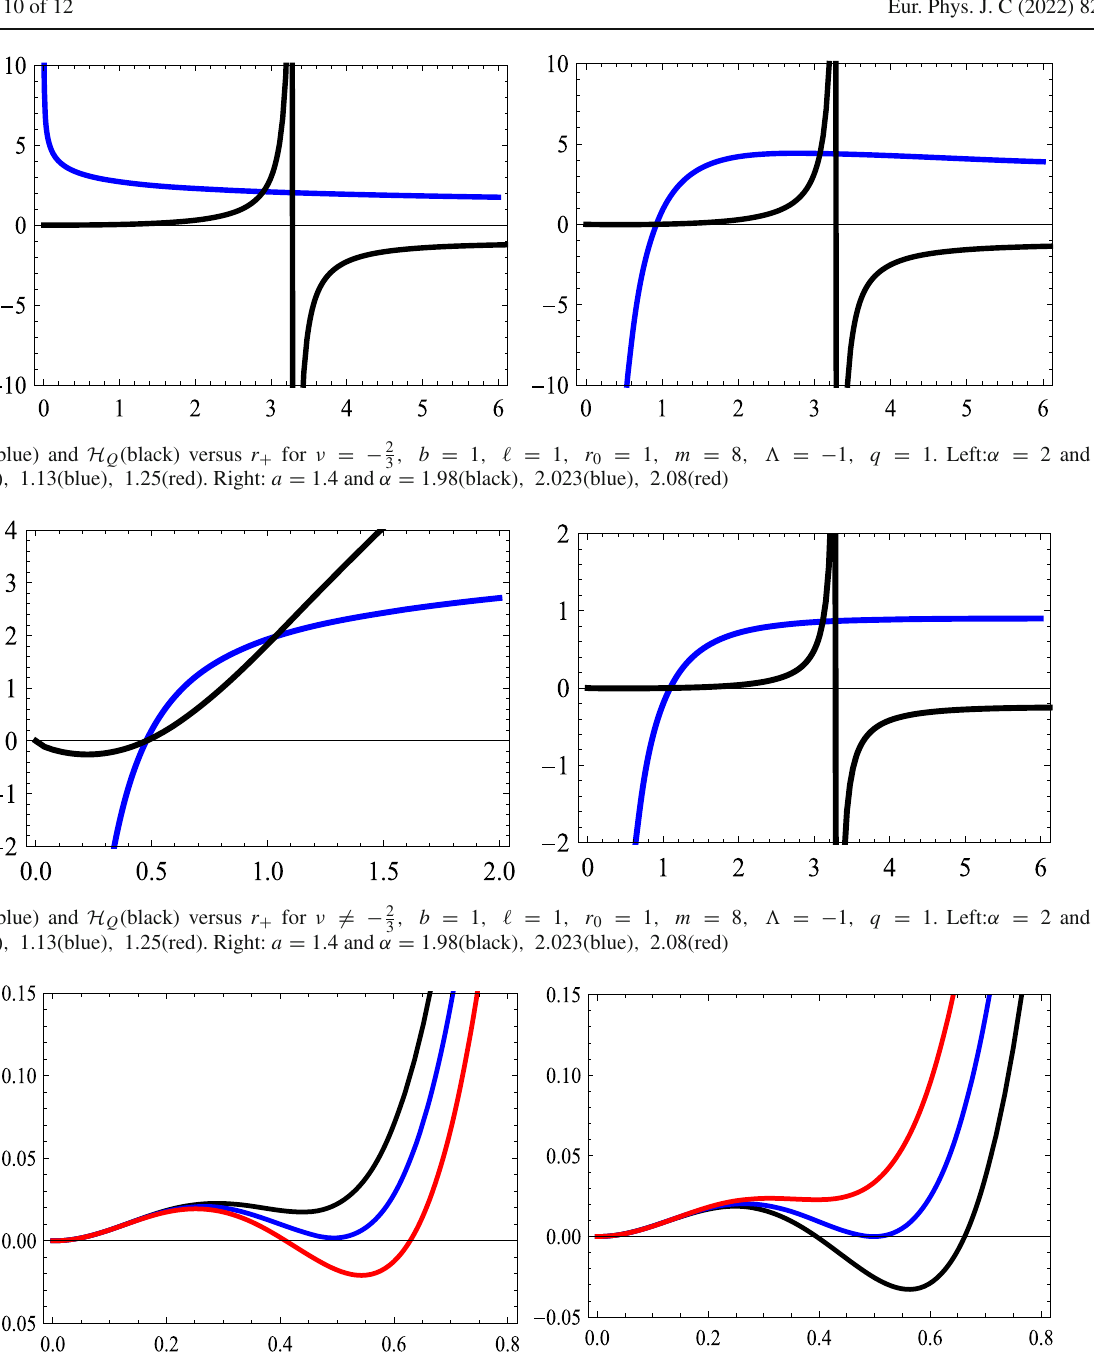
Fig. 5 B ( r ) versus r for b = 1 , α = 2 . 2 , r 0 = 1 , m = 10 , (cid:18) = − 1 , q = 1. Left: ν = − 0 . 37 and a = 1 . 315(black) , 1 . 347(blue) , 1 . 38(red). Right: a = 1 . 44 and ν = − 0 . 373(black) , − 0 . 3758(blue) , − 0 .